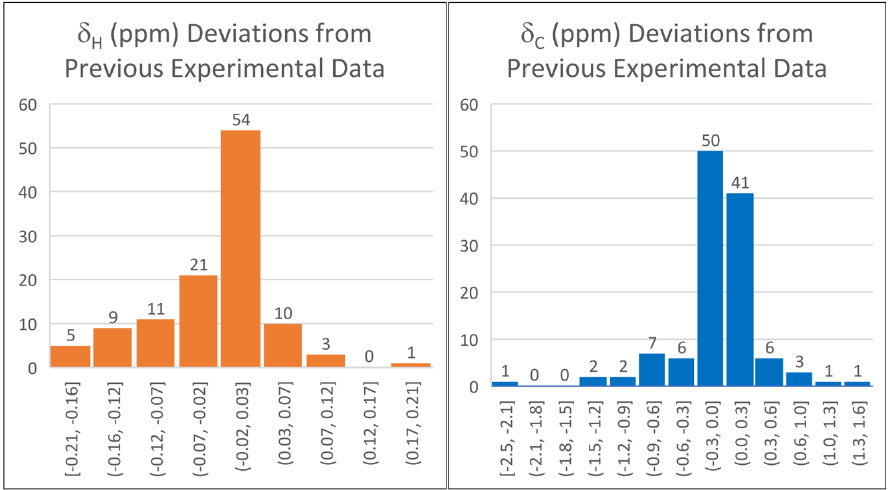
Figure 4. Histogram plots showing frequency of measured differences between experimental data available in the literature compared with re ‐ measured values in this study for 114 proton chemical available in the literature compared with re-measured values in this study for 114 proton chemical shifts and 143 carbon chemical shifts. shifts and 143 carbon chemical